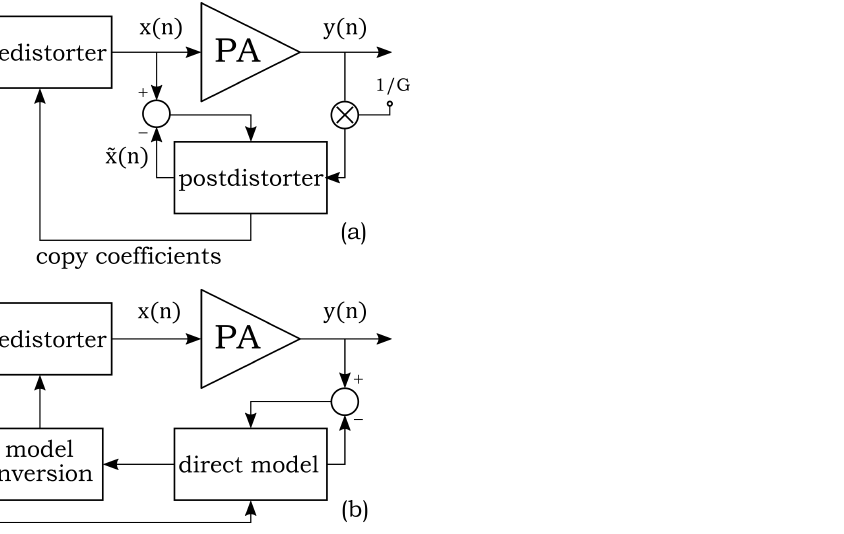
Figure 1. Block diagram for digital predistortion using ( a ) Iterative Learning Architecture (ILA) and ( b ) Direct Learning Architecture (DLA).